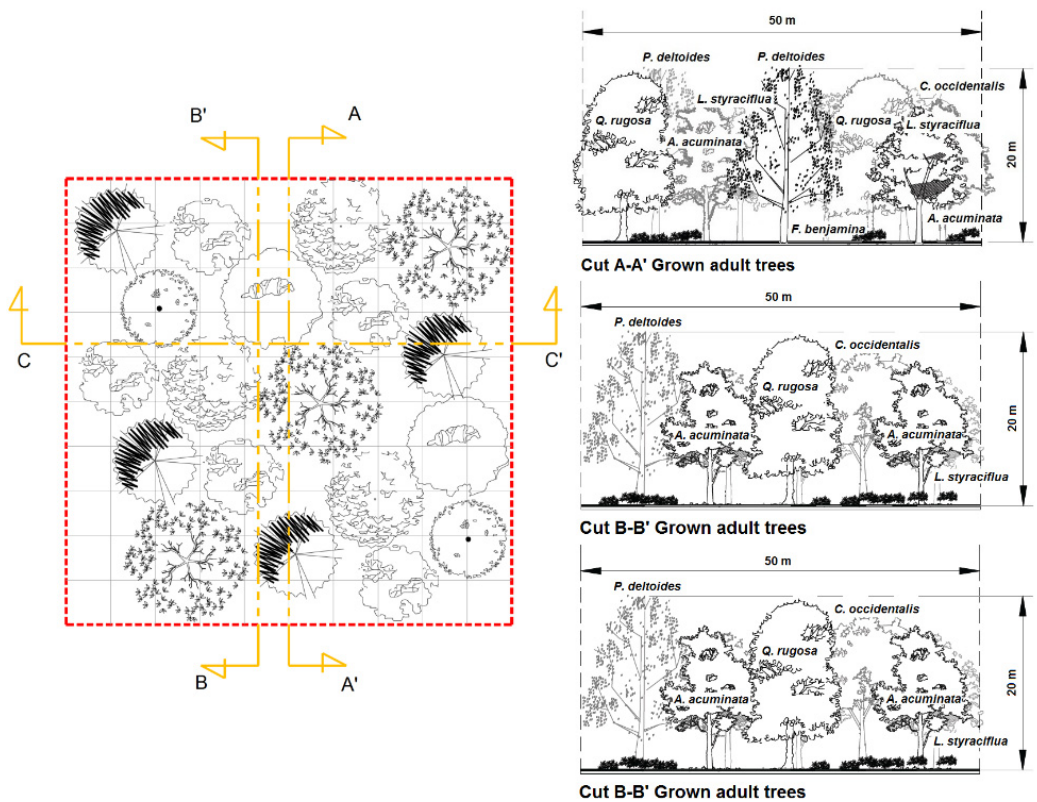
Figure 3. Final outlook of a proposed urban park design of a tree community module showing three different internal profiles as A-A’, B-B’ and C-C’ cuts.